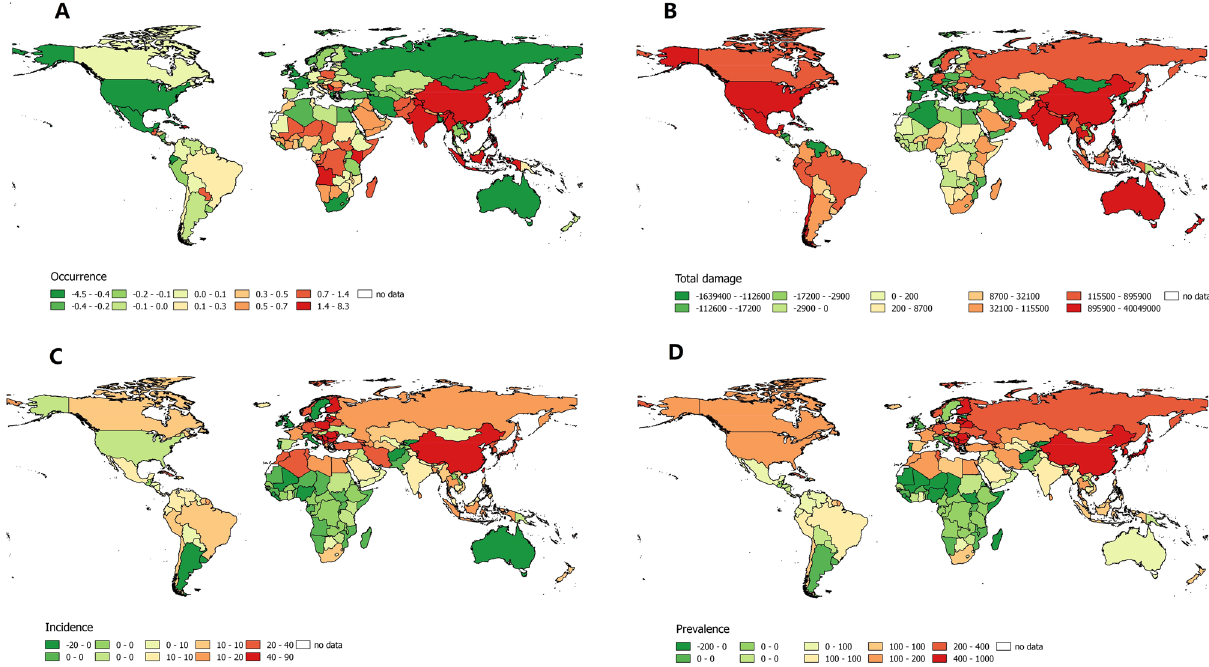
the prevalence of ischemic stroke in both sexes per 100,000 population per year.